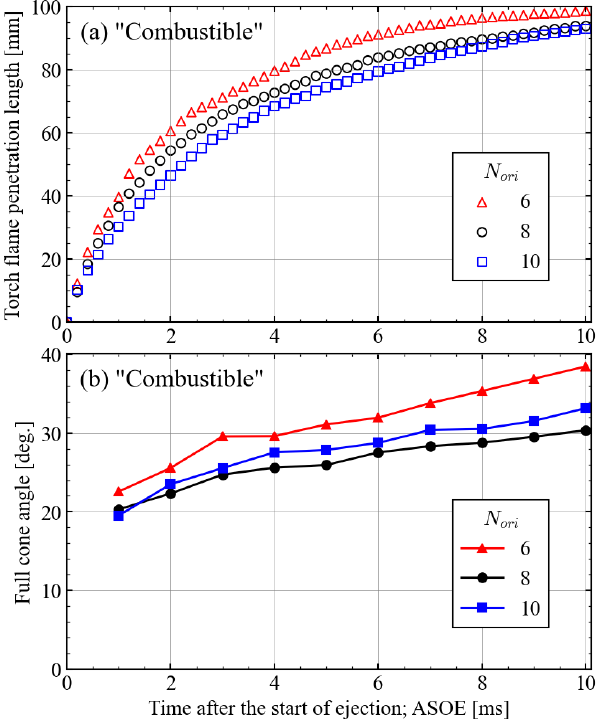
Fig. 11. Time history of (a) penetration, and (b) cone angle of the different number of orifices (N ori = 6, 8, 10) under “combustible” conditions In N = 8, however, most of the torch flames were not ori flattened at 10 ms ASOE. This is consistent with the slow- est growth of the cone angle of N = 8 in Fig. 8. Thus, the ori